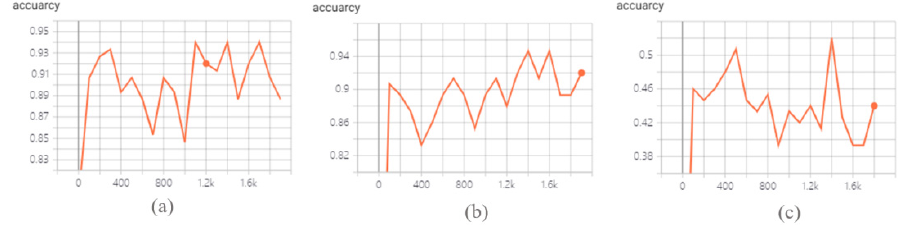
Figure 3. Accuracy changes during CNN prediction training. ( a ) Group 1; ( b ) Group 2; ( c ) Group 3. For Group 1 of hand activities with large-diameter, power-disk and